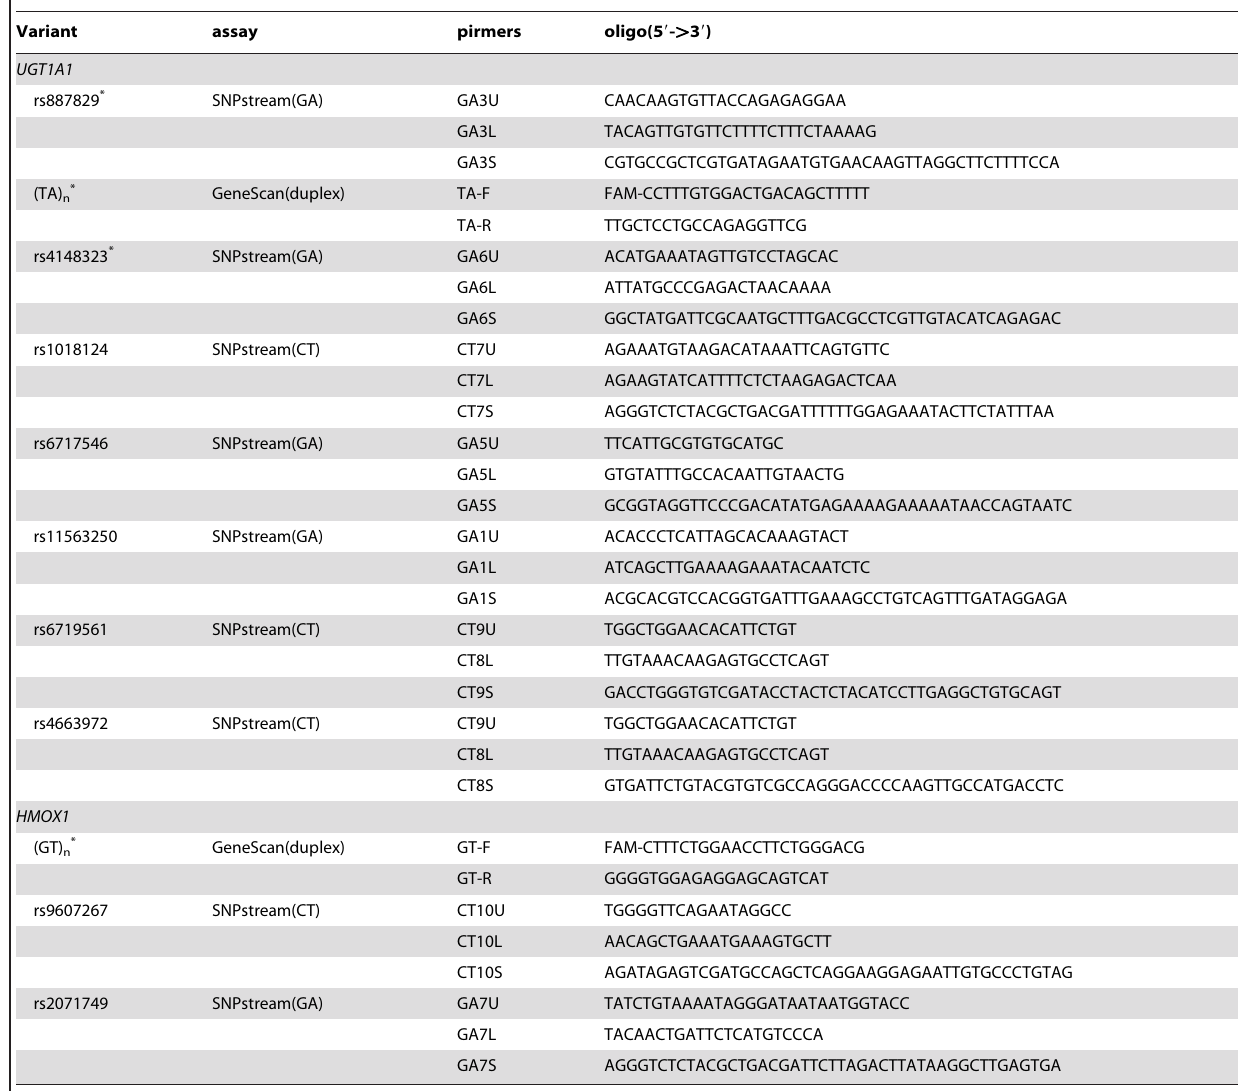
Table 1. Genotyped variants and genotyping